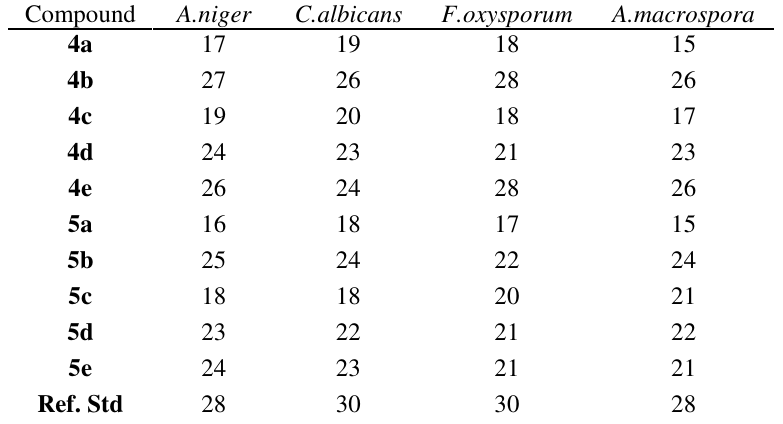
Table 3. Antifungal activity of compounds ( 4a-e ) and ( 5a-e ) (zone inhibition in mm).